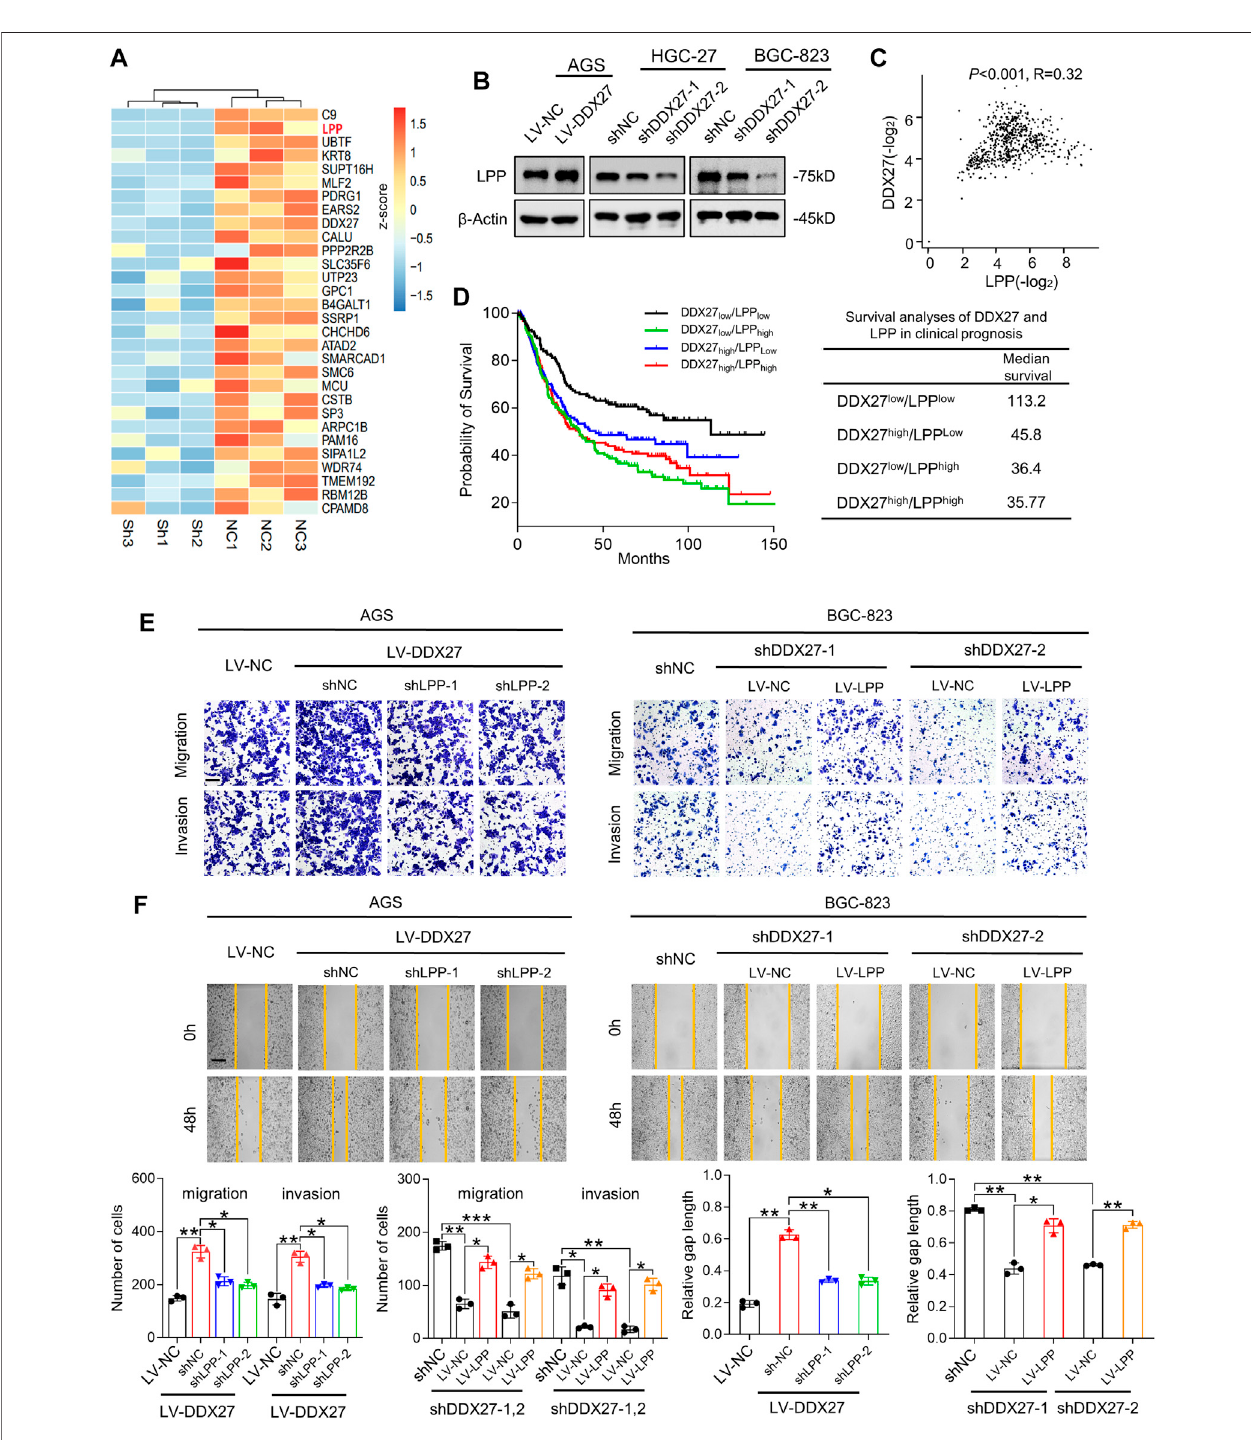
FIGURE 4 | LPP is indispensable for DDX27-mediated GC migration and invasion. (A) Heatmap generated from mass spectrometry analyses of the protein samples isolated from HGC-27 knockdown and control cells (log 2 fold change < − 1; p < 0.05). LPP was identi fi ed as one of the signi fi cantly downregulated genes. (B) Western blot analysis of the LPP expression in DDX27 overexpressing and silencing GC cells. (C) Positive correlation between DDX27 and LPP was analyzed via TCGA and GTEx datasets of the stomach. ( p < 0.001, R = 0.32, by Spearman correlation method). (D) Survival analysis of DDX27 and LPP in clinical prognosis ( n = 630, left) and the median survival in different groups (right, by log-rank test). (E) Trans-well assays showing the migratory and invasive abilities between LPP knockdown (or overexpression) and corresponding control cells with the stable DDX27 overexpression (or knockdown). Scale bars: 12.5 μ m, statistical analyses are exhibited below. (*** p < 0.001, ** p < 0.01, and * p < 0.05, by ANOVA). (F) Wound healing was performed to detect cell motility between LPP knockdown (or overexpression) and corresponding control cells with a stable DDX27 overexpression (or knockdown). Scale bars: 25 μ m, statistical analyses are exhibited as follows. (** p < 0.01 and * p < 0.05, by ANOVA), n ≥ 3, the data are presented as the mean ± SD. LPP can be regulated by DDX27 through alternative splicing.